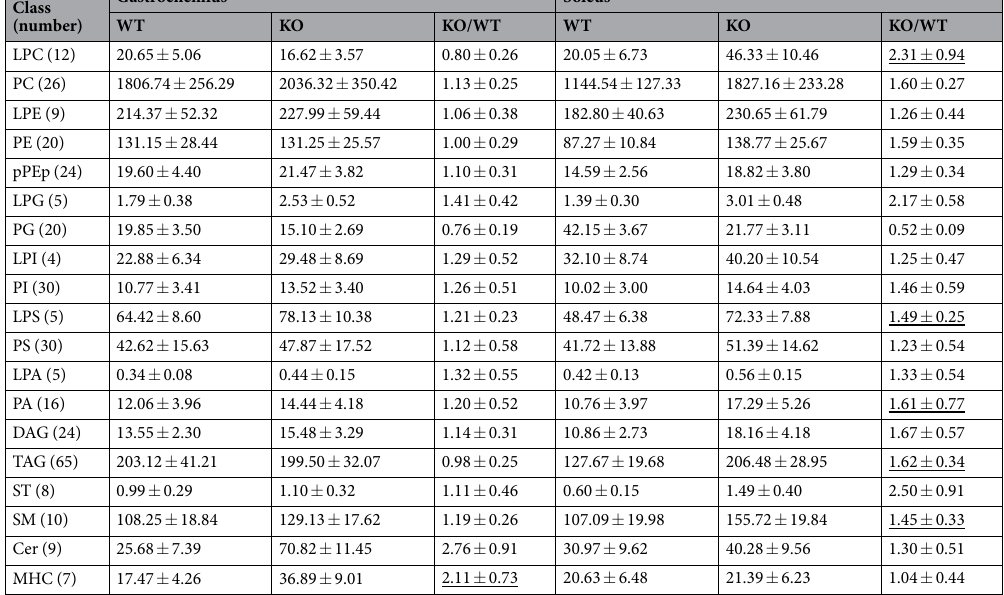
Table 1. Relative ratio (KO/WT) of each lipid category based on total peak area (vs. IS) by nLC-ESI-MS/MS with SRM. Lipid class with underline shows significant difference between WT and KO with p < 0.05. The numbers in the parentheses of each lipid category represent the number of species examined in quantitative